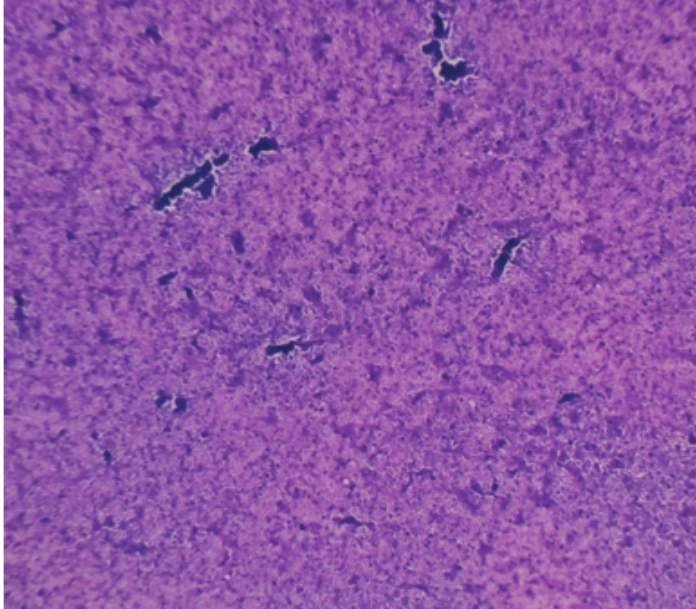
Figure 3 : Photomicrograph showing caseous necrosis (Pattern C); 100x